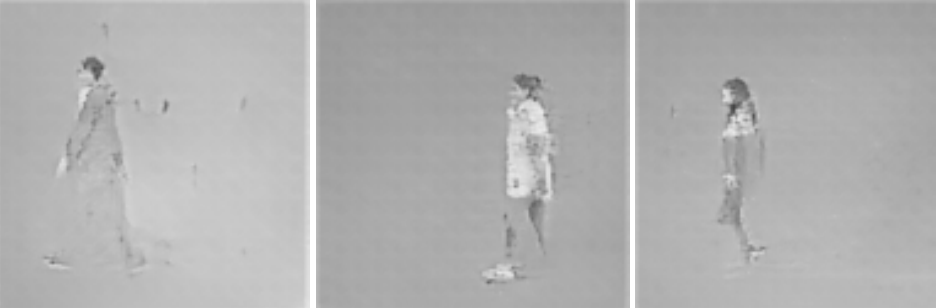
Figure 3. Failed reconstruction images based on the EV-Gait dataset [19].